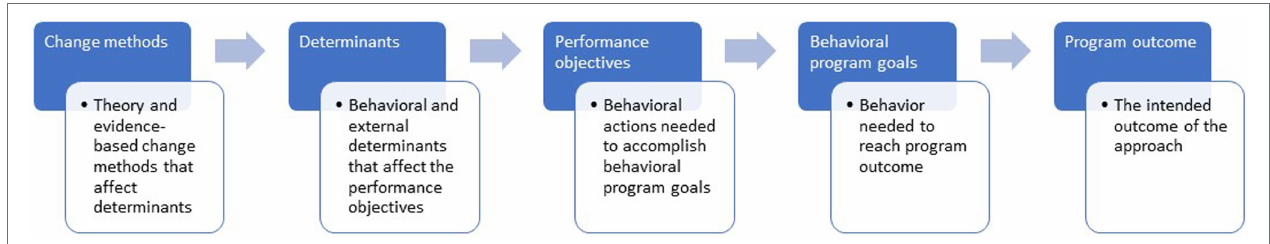
FIGURE 2 | Steps of the behavioral analysis resulting in a logic model of